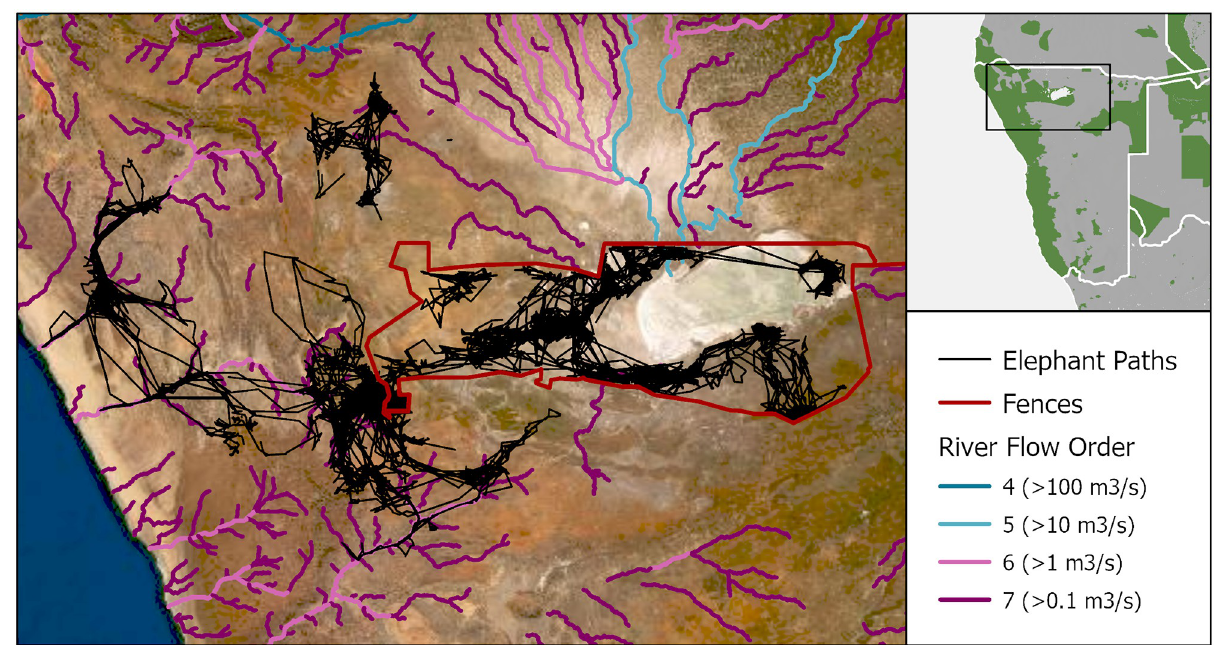
Fig 4. Map of elephant paths in northern Namibia. Fenced boundaries (red) [4] around Etosha National Park prevent elephant movement (black) towards the north, east, and south. The arid landscape restricts movement in the west to riverbeds (symbolised by average annual flow rates from blue to purple) [30]. Green areas in the subset map mark protected areas from the WDPA [35]. Basemap Source: ESRI,